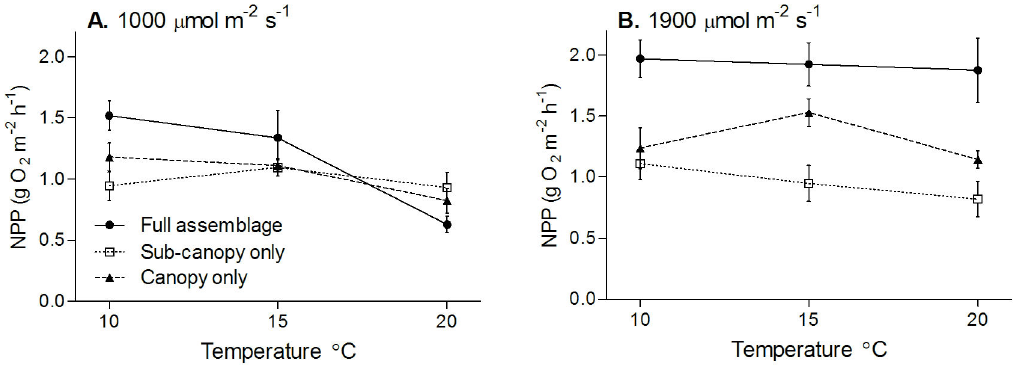
Figure 1. Effects of temperature on NPP of intact in situ macroalgal assemblages dominated by a canopy of H. banksii , the sub-canopy only and the canopy only (mean ±SE). NPP is shown at moderate irradiance, binned between 900-1100 μmol m -2 s -1 (A) and high irradiance, binned between 1800-2000 μmol m -2 s -1 (B). doi: